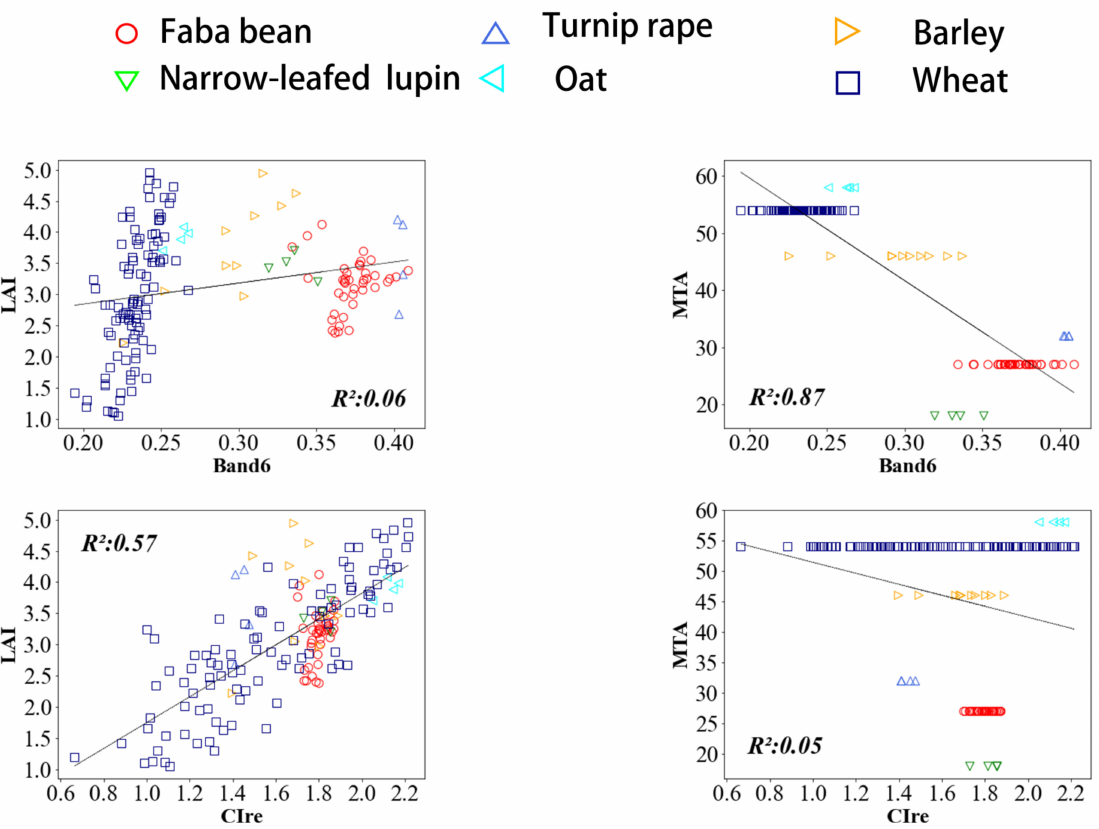
Figure 3. Correlations between simulated Sentinel-2 band 6 (740 nm) and the vegetation index CI RE with MTA and LAI in field-measured